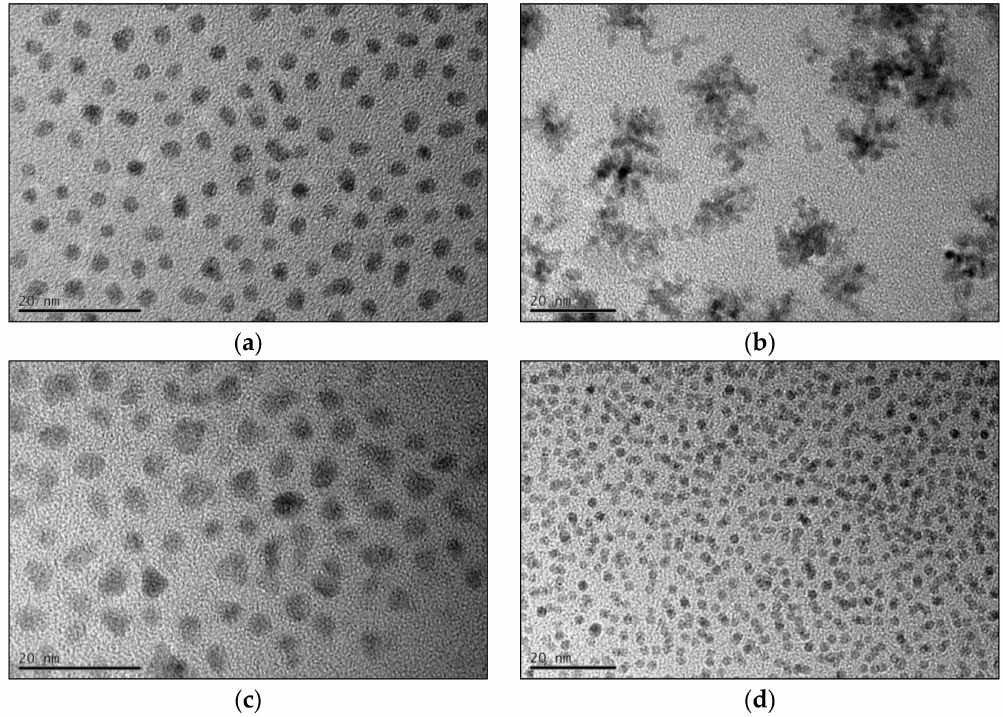
Figure 4. TEM images of the final prepared fcc-FePt nanoparticles using BnOH ( a ), BnNH 2 ( b ), TEG ( c ), and BnOBn ( d ).